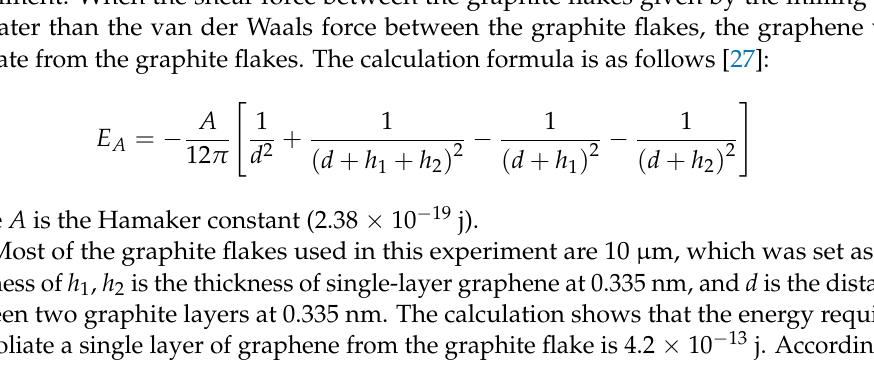
Figure 7. Energy model of London–van der Waals model between two parallel plates.